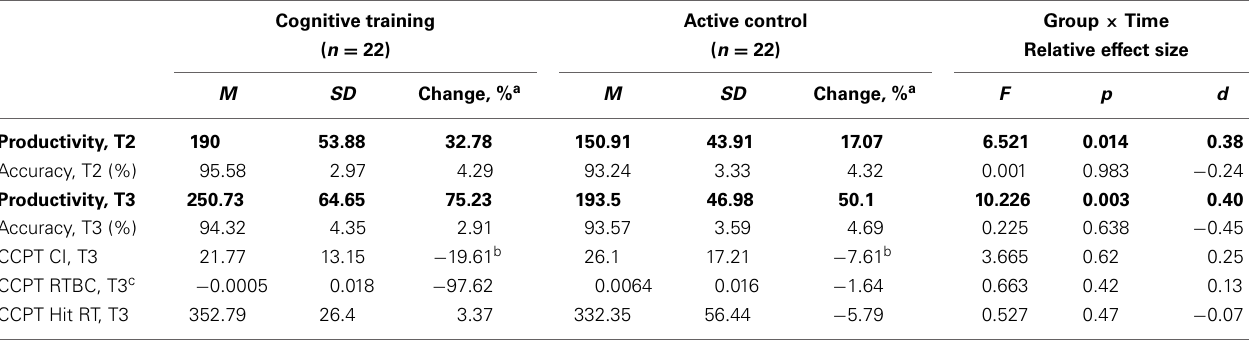
Table 3 | Estimated marginal means, change rates and summary statistics for outcome variables by training group and assessment time. Cognitive